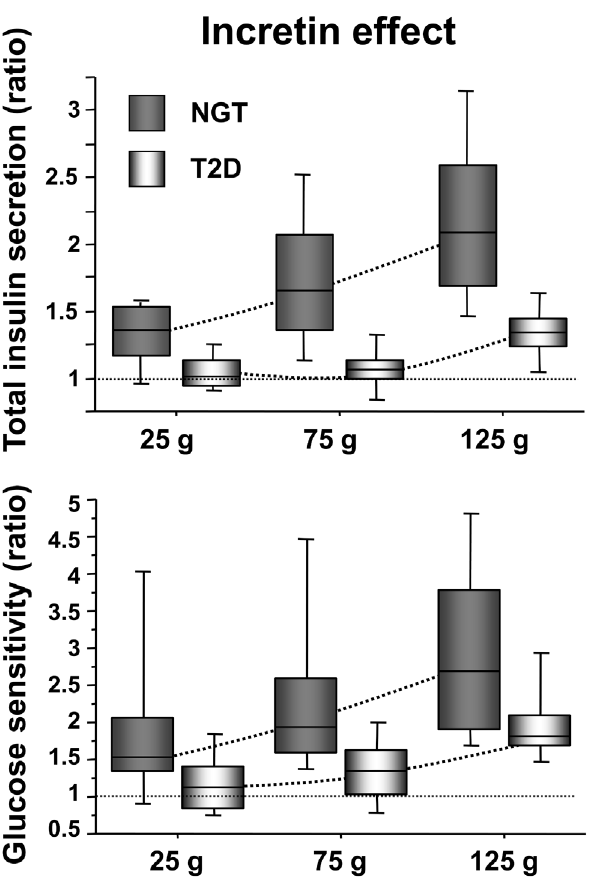
Figure 3. Incretin effect on total insulin secretion and glucose sensitivity. Incretin effect as the OGTT/IIGI ratio of total insulin secretion ( top panel ) and glucose sensitivity ( bottom panel ) in NGT and T2D subjects by glucose dose.